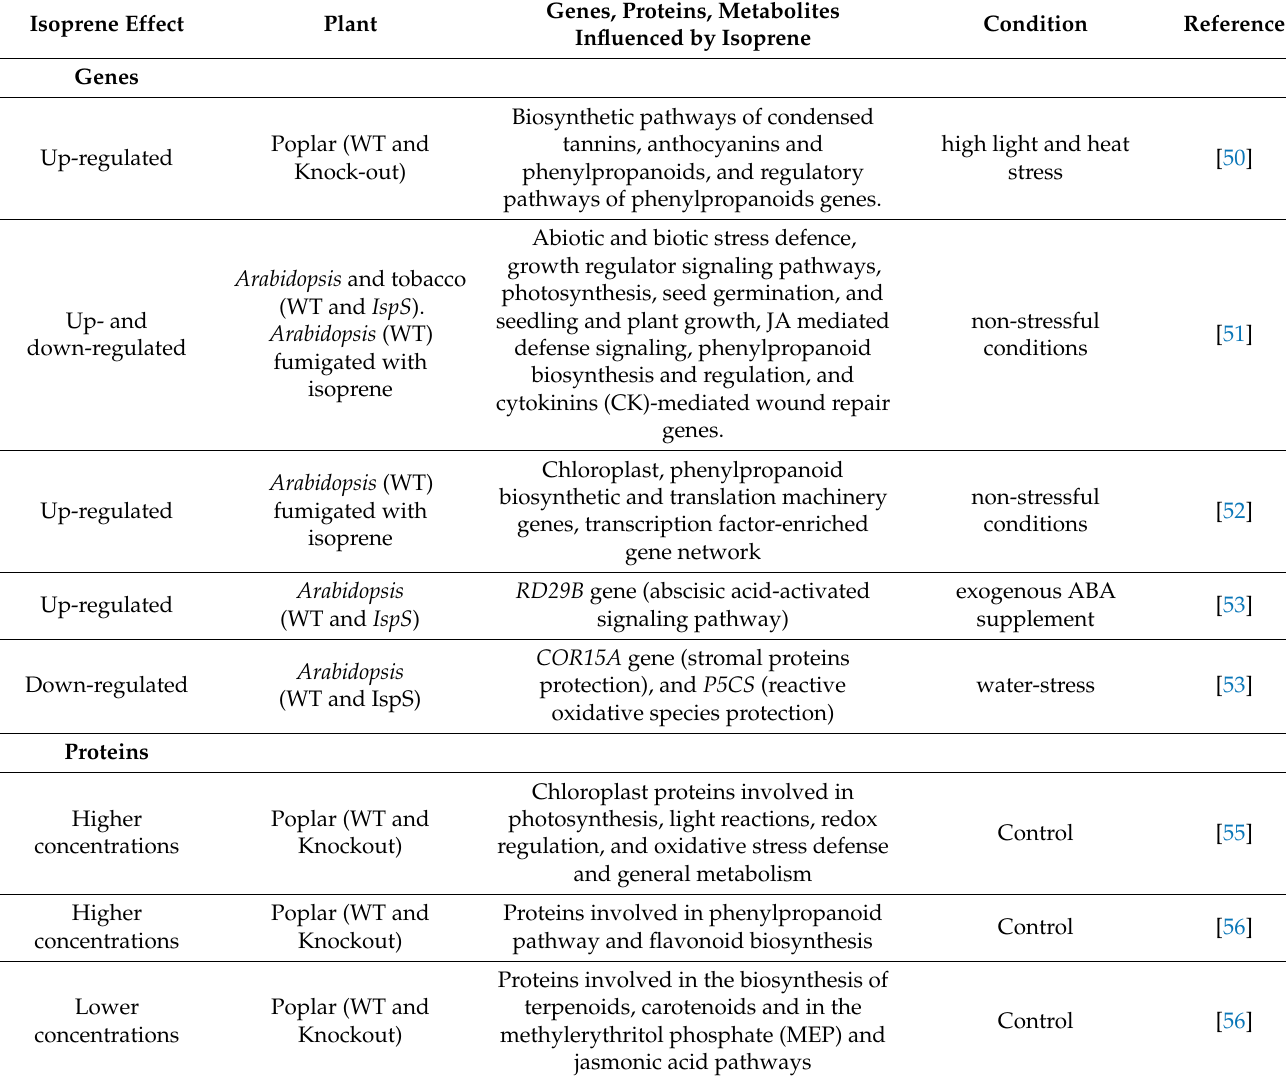
Table 1. Summary of studies highlighting differences in gene expression, proteins and metabolites in isoprene-emitting and non-emitting plants under different experimental conditions. Up-regulation or down-regulation of gene transcripts, or higher or lower concentrations of proteins and metabolites in isoprene-emitting plants with respect to the non-emitting ones are